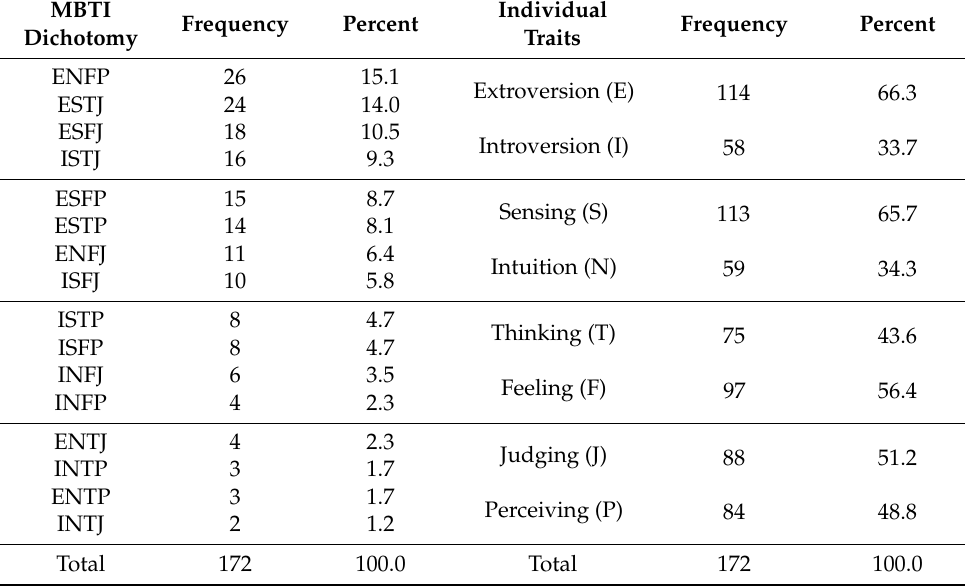
Table 1. Distribution of MBTI personality types among the